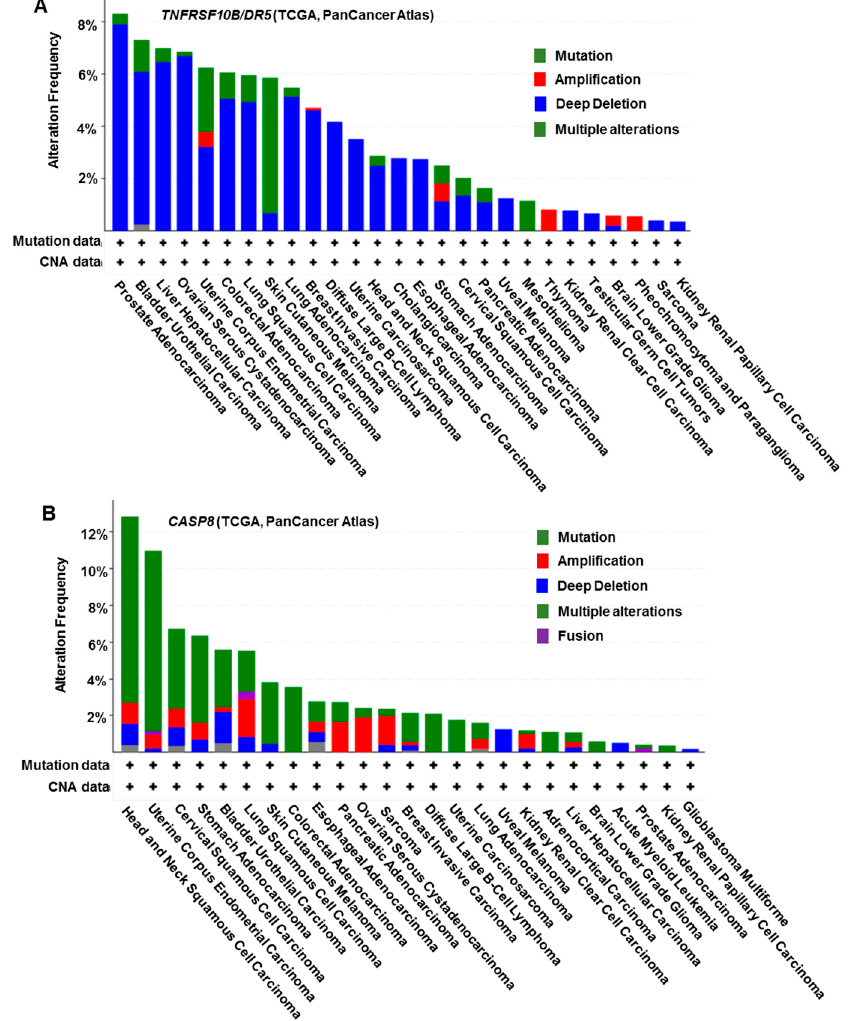
Figure 2. DR5 (TNFRSF10B) and CASP8 gene mutations in different cancer types with TCGA data analysis. These data were generated from the cBioPortal website at https://www.cbioportal.org/ (accessed on 16 March 2021).